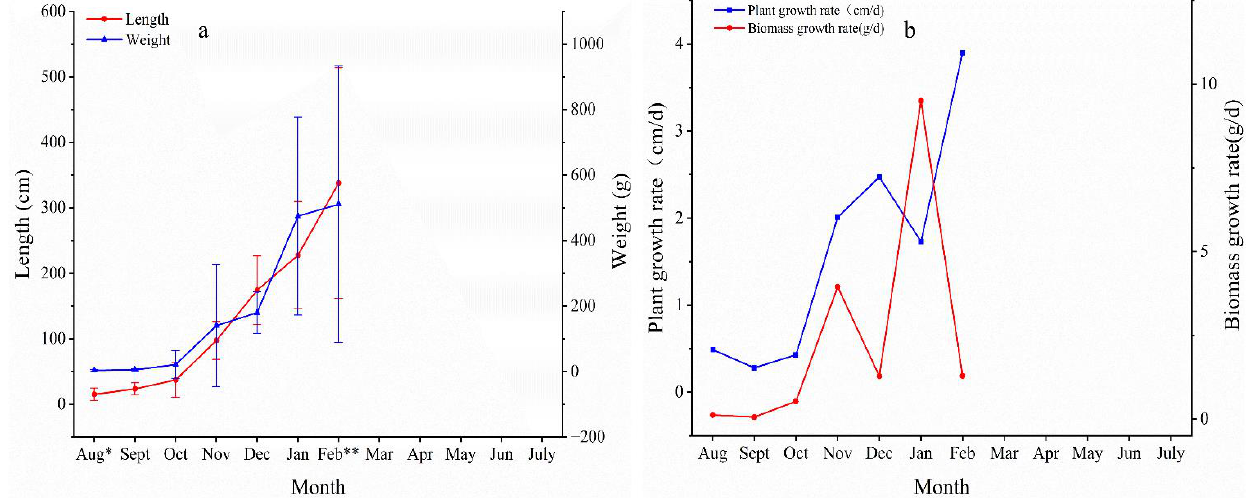
Figure 6. Monthly variation in the plant length and individual biomass of S. horneri in the aquaculture area; ( a ) monthly variation in plant length and biomass; ( b ) rate of length and biomass variation. * Appearance of vesicles; ** appearance of receptacle.